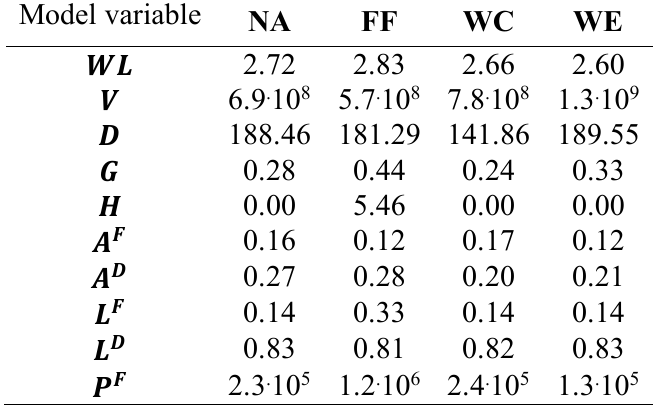
Table A3. Average values of different model variables obtained for the synthetic experiment additional scenario #2 with dam construction and four water management strategies (NA: No Actions; FF: Fighting Floods; WC: Water Conservation; WE: Water